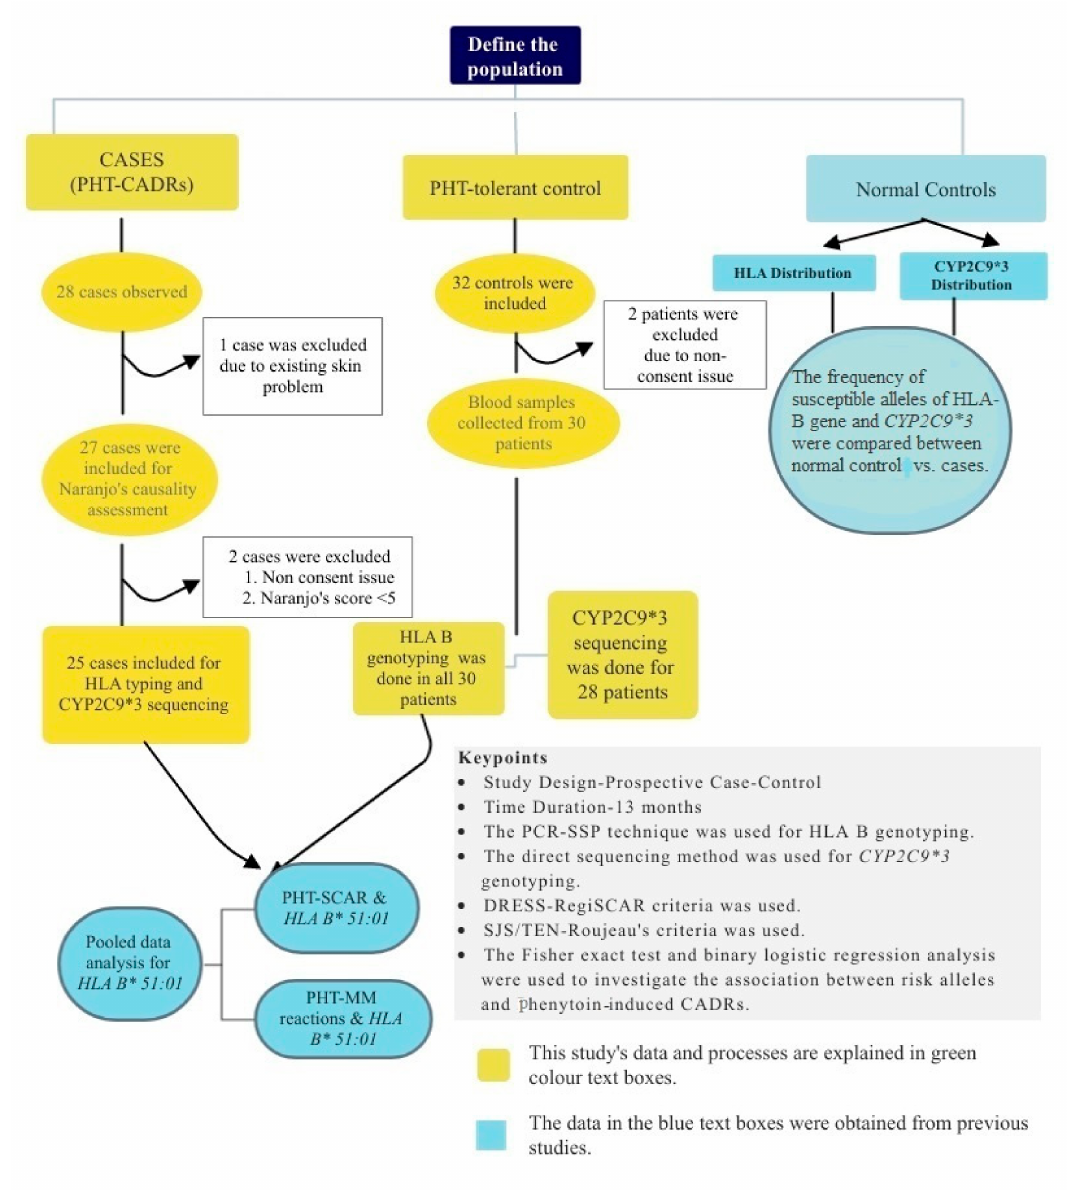
Figure 1. Flowchart of study